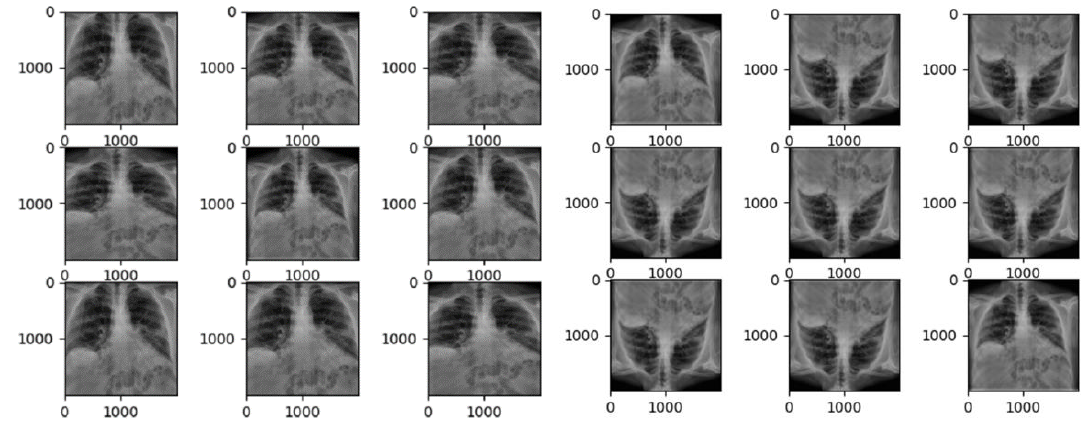
Figure 3. CXR Data Augmentation, Zoom and Flip Images.